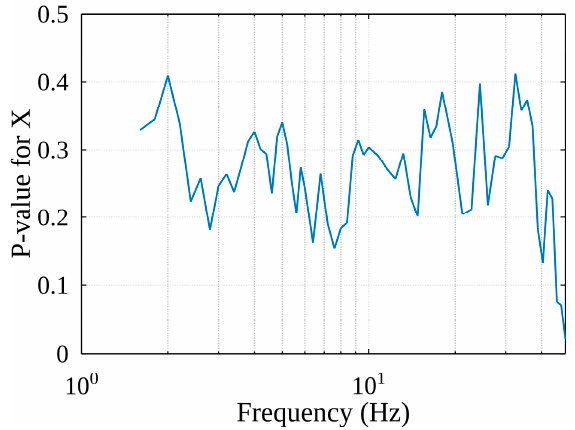
Figure 21. p -value of the selected distribution function.